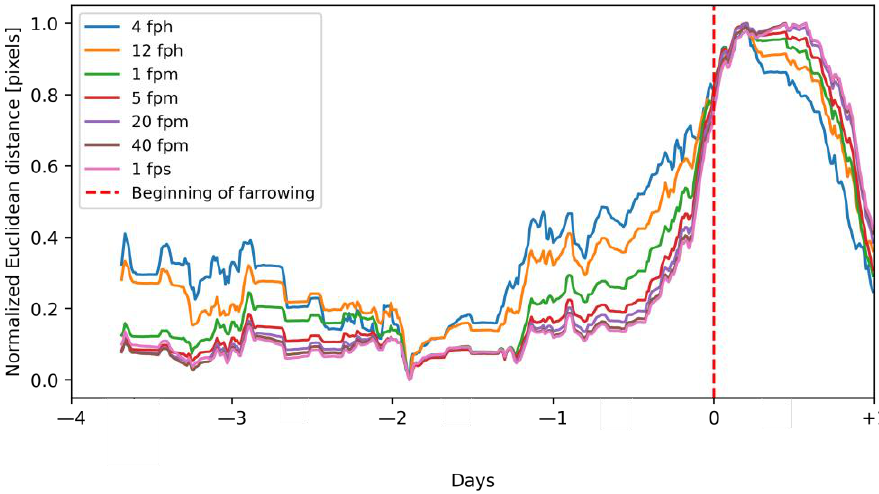
Figure 8. Normalized Euclidean distance of activity related to nest-building